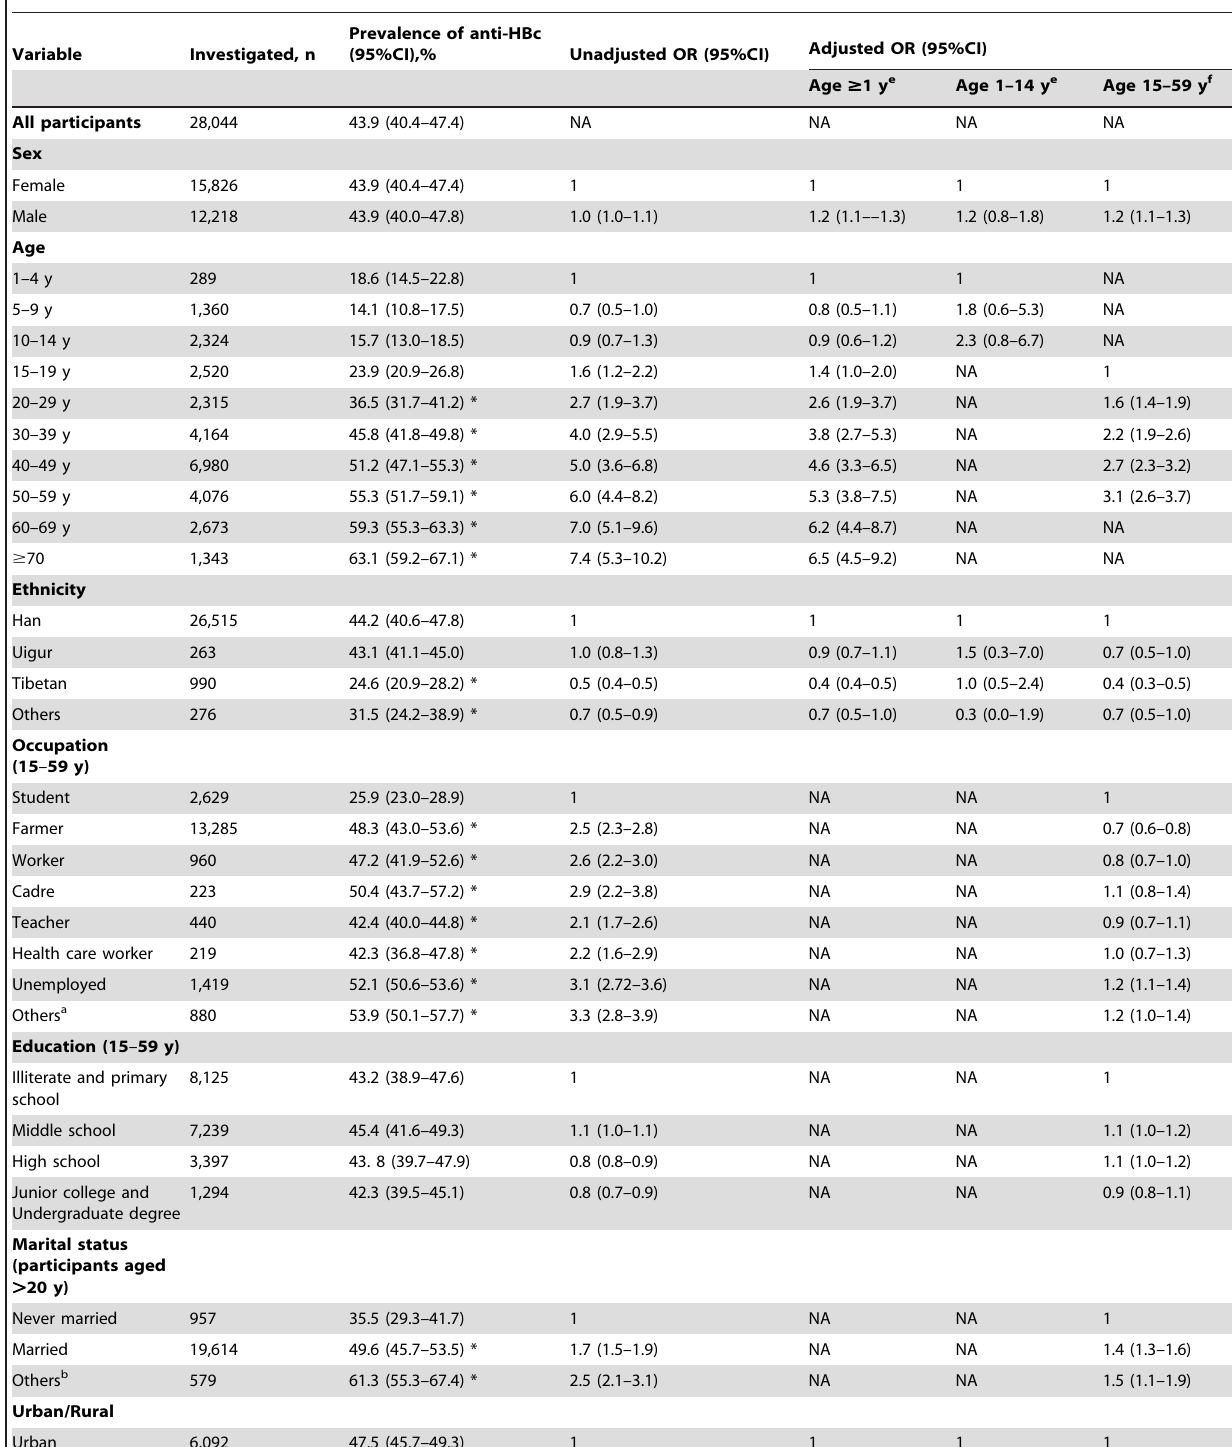
Table 2. Prevalence and Determinants of Exposure to Hepatitis B Virus (Positive Anti-HBc) Among Persons $ 1 Year of Age in Wuwei City,